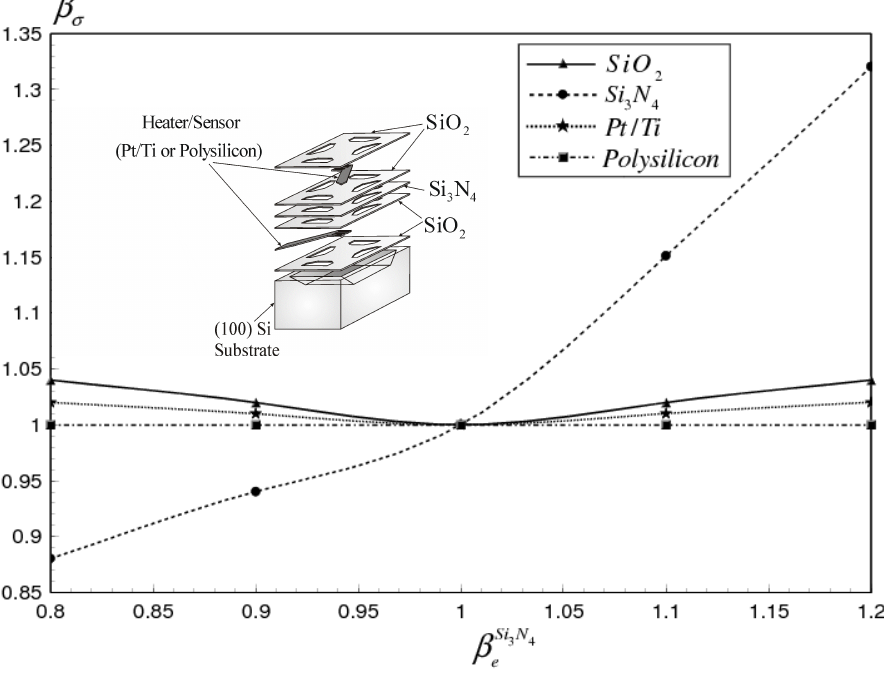
Figure 8. Effect of the variation of the coefficient of thermal expansion of Si